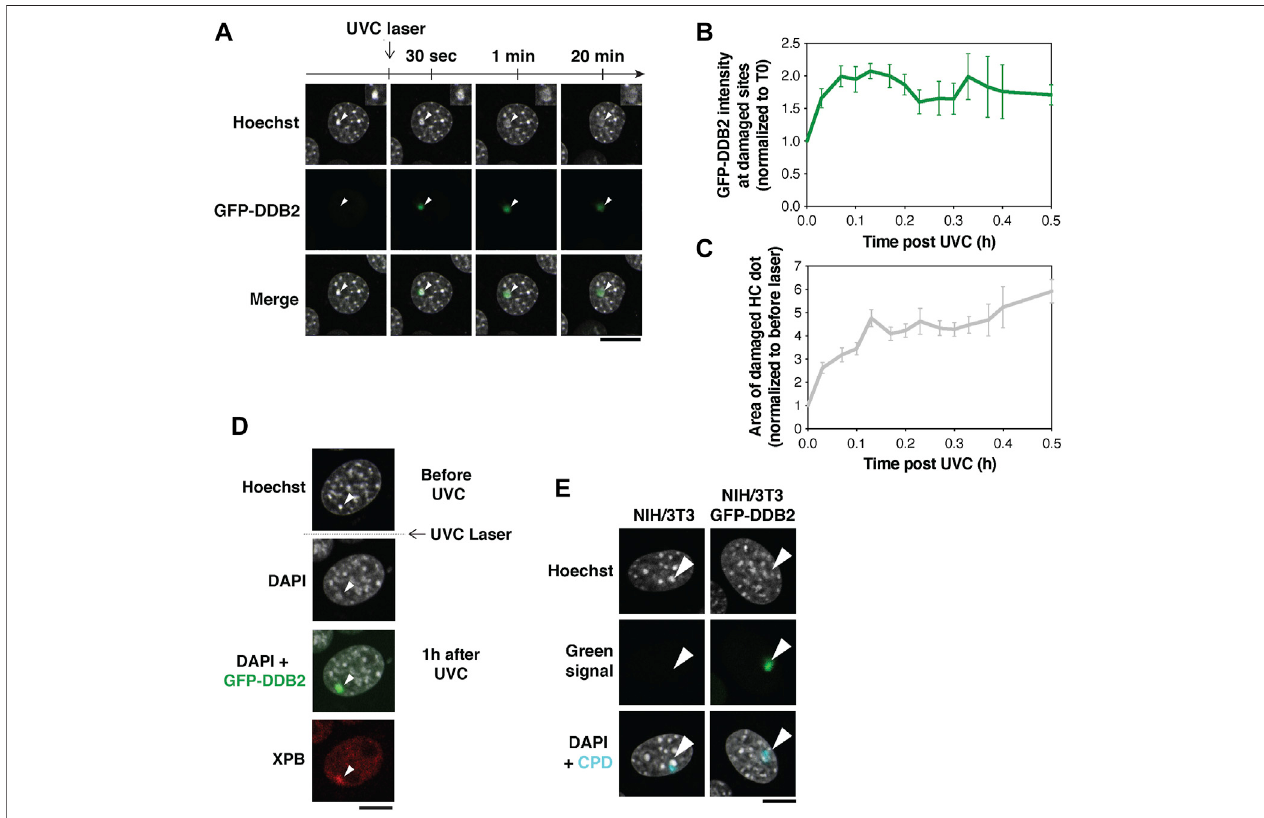
FIGURE 3 | Pericentric heterochromatin decompaction and recruitment of UV damage repair proteins. (A) Decompaction of pericentric heterochromatin following UVC laser damage analyzed in NIH/3T3 cells expressing GFP-DDB2 (UV damage sensor). (B,C) Quanti fi cation of GFP-DDB2 intensity in damaged heterochromatin (B) andchromocenterarea (C) relativetobeforedamage.Dataarepresentedasmeanvalues±SEMfrom12 – 45cells(dependingonthetimepoint)scoredinatleasteleven independent experiments. (D) Recruitment of XPB repair protein analyzed by immuno fl uorescence 1 h after UVC laser micro-irradiation in NIH/3T3 GFP-DDB2 cells. Antibodies used: primary antibody anti-XPB (Santa cruz Biotechnology sc-293, 1:400), secondary antibody anti-rabbit Alexa Fluor 594 (Invitrogen A11037, 1: 1,1000). (E) Hoechst photoconversion control after UVC laser micro-irradiation in NIH/3T3 cells (parental cell line vs cells expressing GFP-DDB2) followed by immuno fl uorescence for UV lesions (Cyclobutane Pyrimidine Dimers, CPD) 30 min after irradiation. Antibodies used: primary antibody anti-CPD (Cosmo Bio CAC-NM- DND-001,cloneTDM2,1:1,000),secondaryantibodyanti-mouseAlexaFluor647(InvitrogenA21236,1:1,000).Imagingsettingswerekeptthesameforbothcelltypes. The arrowheads point to damaged chromocenters. All microscopy images are confocal sections. Scale bars, 10 μ m. Data from Fortuny et al. (2021).